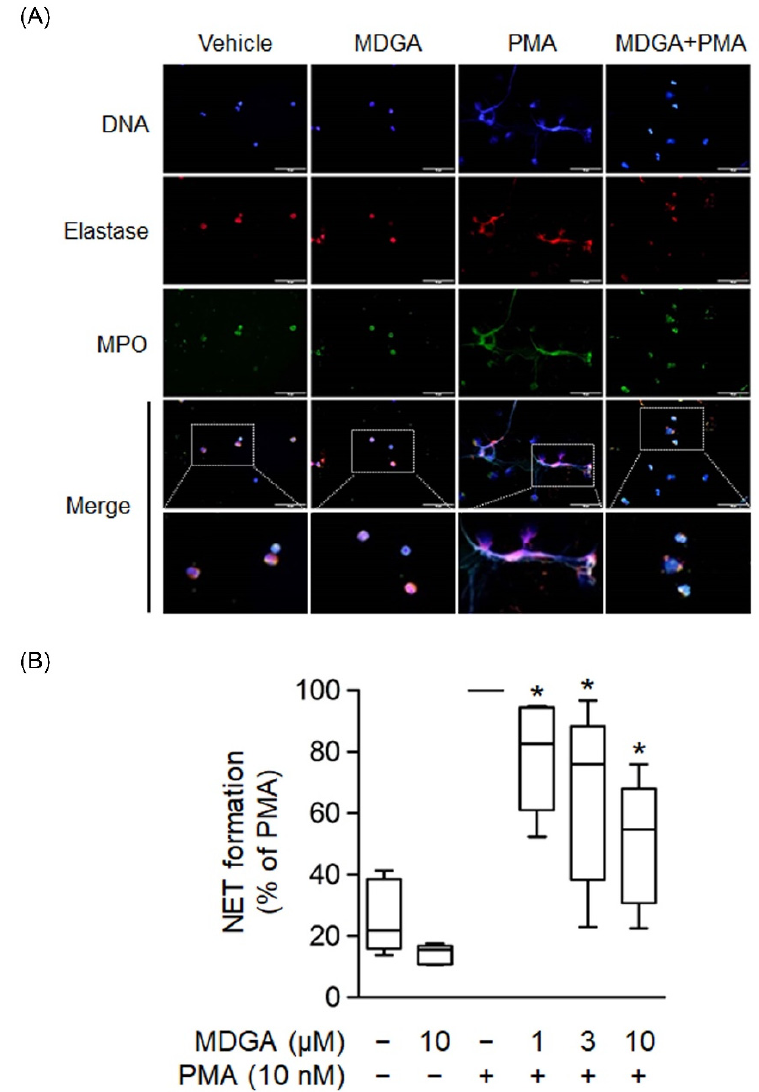
Figure 6. meso -Dihydroguaiaretic acid (MDGA) reduces NET formation. ( A ) Neutrophils incubated with DMSO (0.1%) or MDGA (10 µ M) and stimulated with PMA (10 nM) were stained with anti- elastase (red) and anti-myeloperoxidase (MPO, green) antibodies. Hoechst 33342 (blue) demonstrated DNA. Scale bars are 50 µ m ( n = 3). Scar bar: 50 µ m. ( B ) Neutrophils were incubated with DMSO (0.1%) or MDGA (1, 3, and 10 μ M) and then stimulated with PMA. The amount of free DNA was measured by SYTOX Green. All data are shown as the mean ± S.E.M.* p < 0.05 vs. activated control ( n = 5).